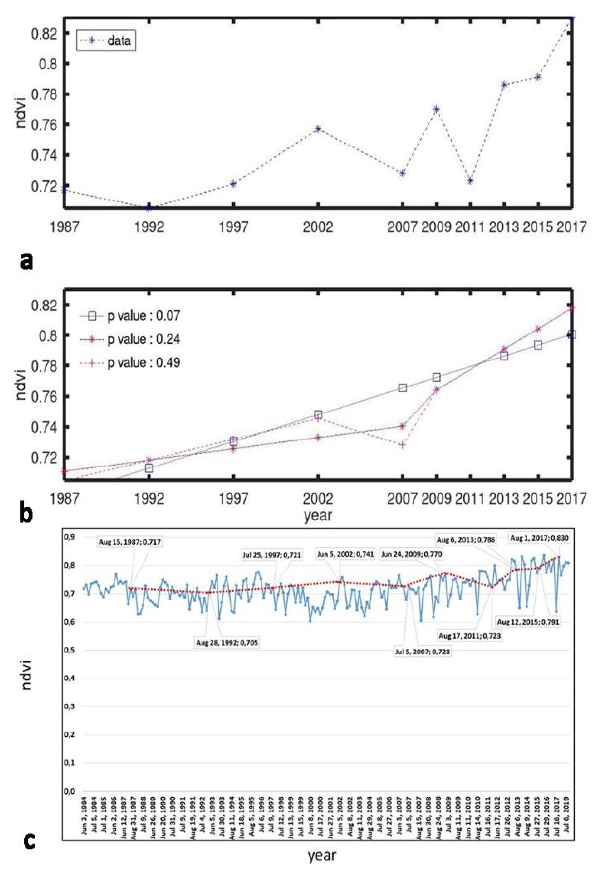
Figure 6. Landtrendr Algorithm results for the second test region, (a) Raw time series, (b) Three different regression models with p values obtained after f statistics test, (c) GEE NDVI time